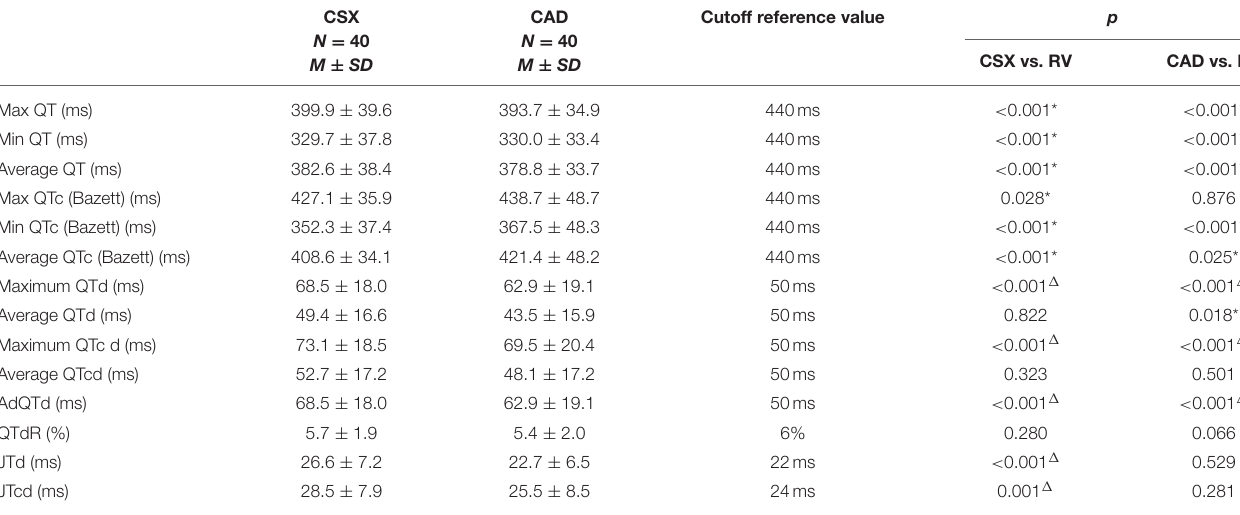
TABLE 3 | Comparisons of QT derived values of CSX and CAD patients with the cutoff reference